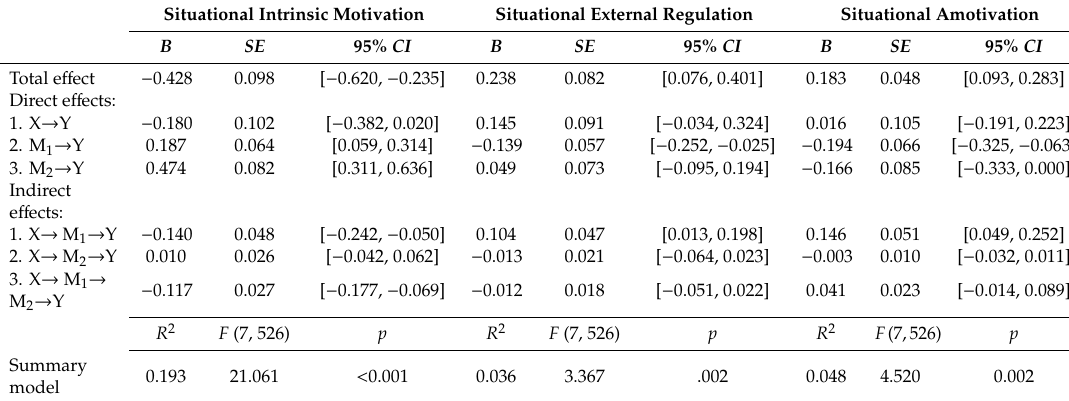
Table 3. Total, direct and indirect e ff ects of weight status [non-overweight (reference) vs. overweight; X] on motivation associated with fitness testing in physical education (Y), mediated by global physical fitness index (M1) and perceived physical fitness (M2).